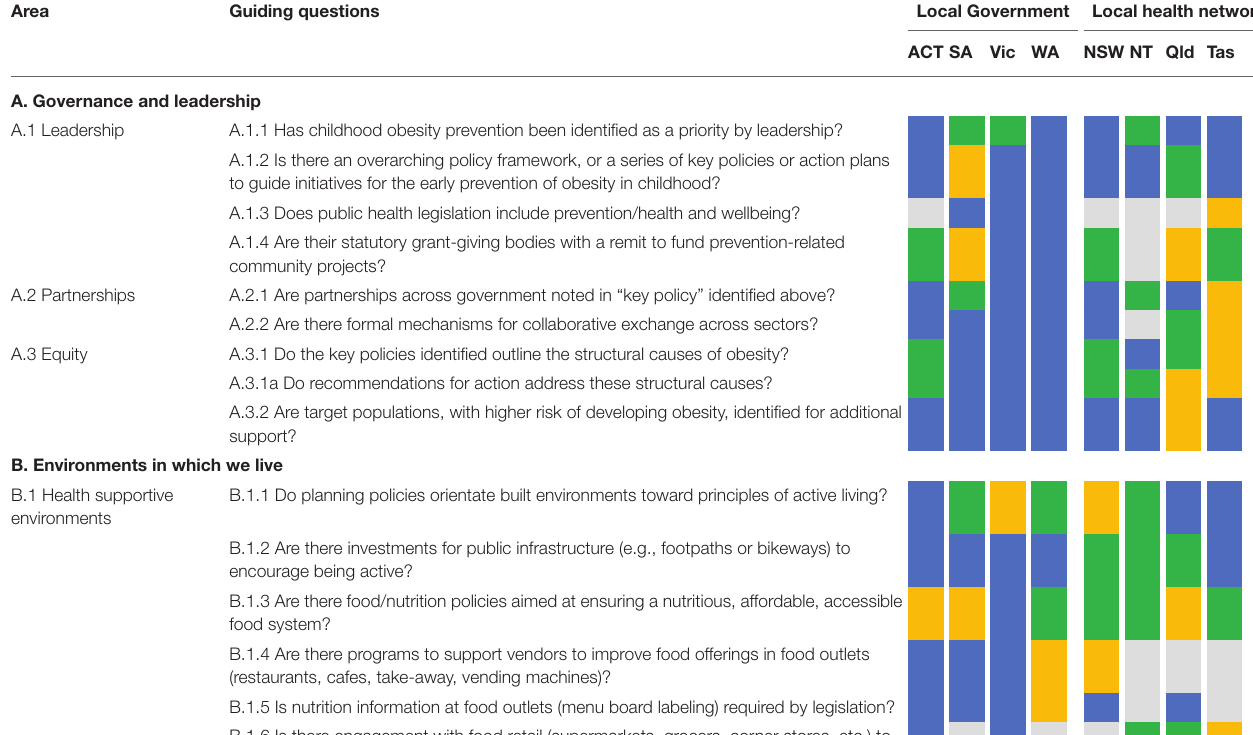
TABLE 2 | Policy mapping tabulated results, by Health Promotion Model type.